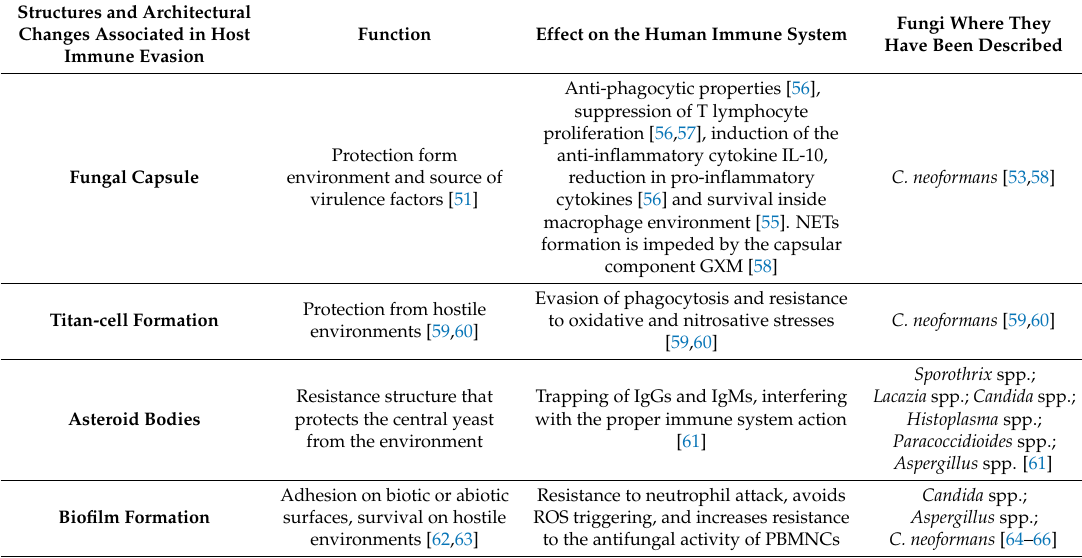
Table 2. Fungal structures involved in the host immune